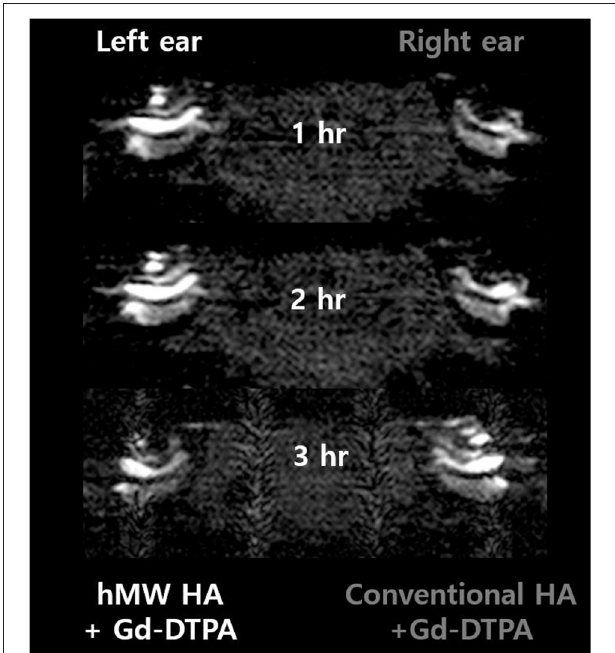
FIGURE 2 | Short-term cochlear enhancement patterns after intratympanic (IT) gadolinium (Gd) injection with two different vehicles. Gd-DTPA was delivered using a high-molecular-weight (hMW) hyaluronic acid (HA) vehicle in the left ear and a conventional HA vehicle in the right ear. Qualitatively, the left cochlea, which was treated with Gd loaded in hMW HA, was brighter than the contralateral